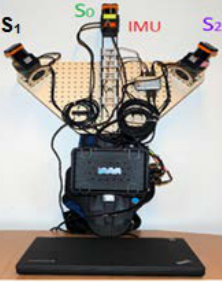
Figure 1. The used laptop and the current backpack system with four sensors mounted: three scanners S 0 , S 1 , and S 2 and Xsens MEMS IMU (below S 0